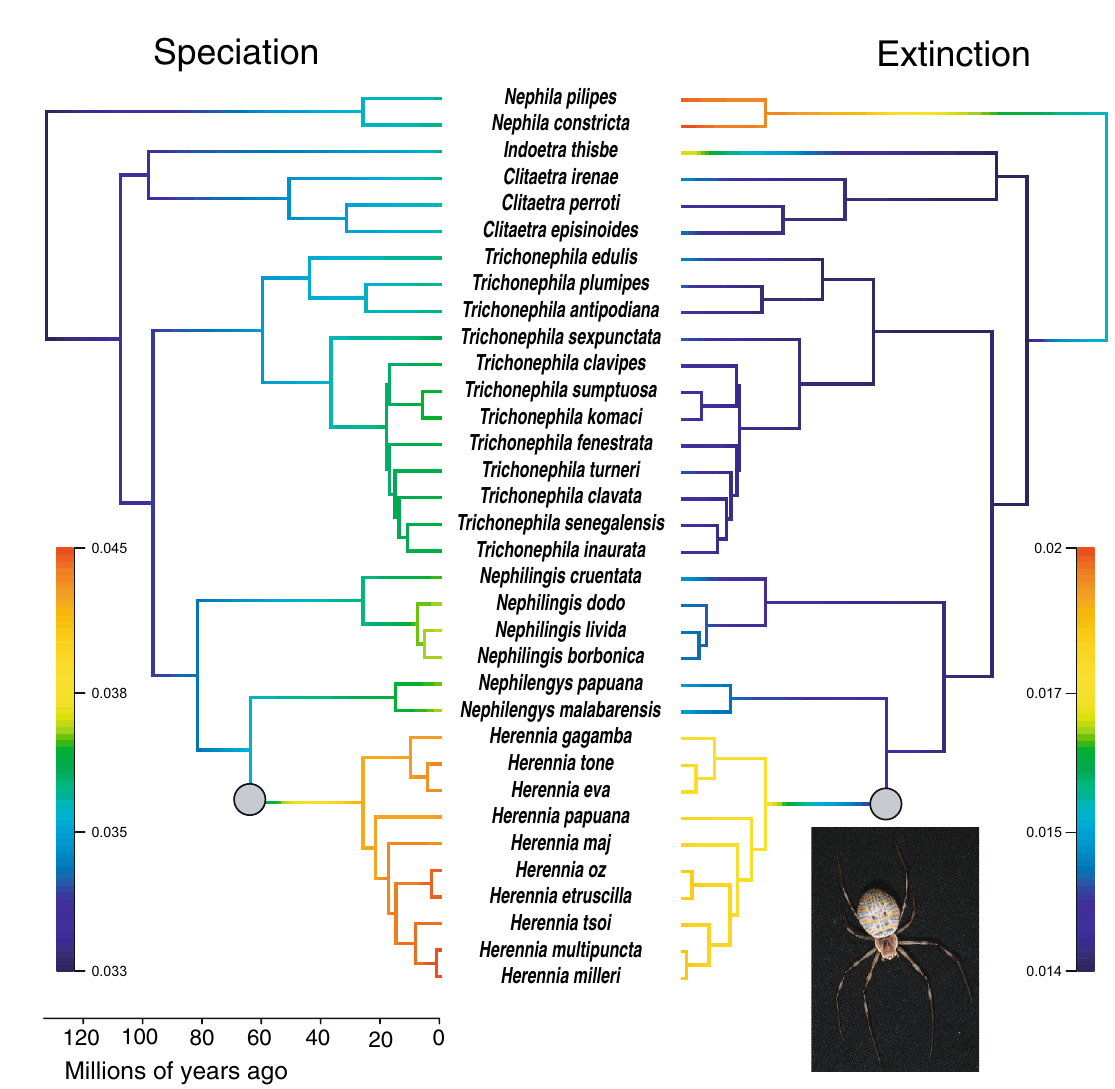
Figure 4. Macroevolutionary rate inference using two methods. BAMM phylorate plots show speciation and extinction rate dynamics in the nephilid phylogeny. Colours denote relative intensity of speciation and extinction along branches. Grey dots signify the location of a shift in diversification rate, inferred by MEDUSA. It detected increased diversification in the genus Herennia (visually presented by H. eva ; own photograph) relative to the rest of the